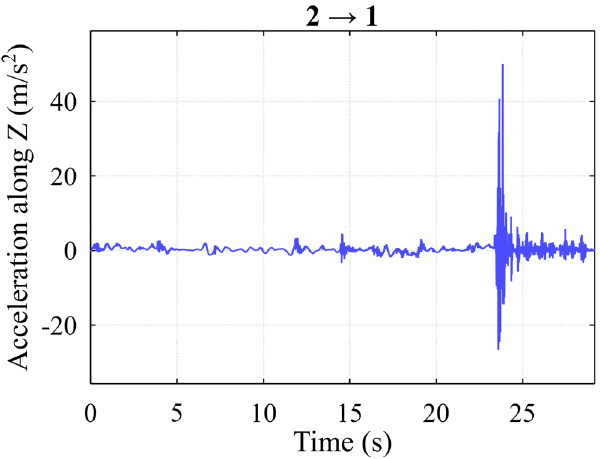
Figure 6. Spreader accelerations along the A-axis: Example A.